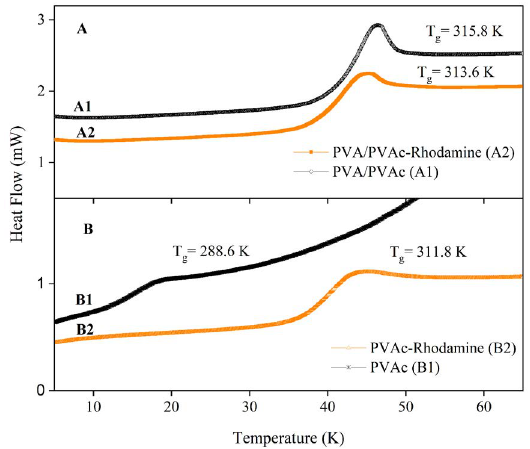
Figure 6. DSC curves of A) PVA/PVAc-Rhodamine (A2) and PVA/ PVAc microspheres (A1), B) PVAc-Rhodamine (B2) and PVAc microspheres (B1).